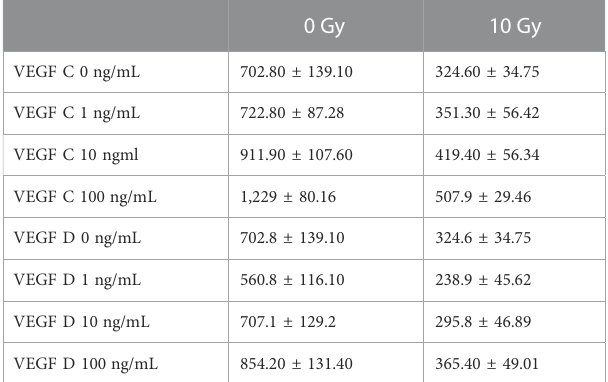
TABLE 1 The effect of VEGFC and VEGFD stimulation at 0 ng, 1 ng, 10 ng and 100 ng/mL concentrations, on the proliferation of 0 Gy and 10 Gy LEC. Data represented as mean ± SEM with assays completed with a minimum of 3 biological and technical